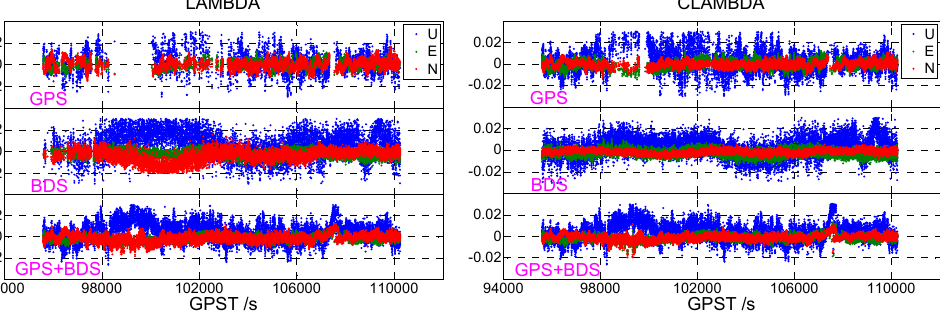
Figure 3. East (E) / north (N) / up (U) deviation sequence diagram (( left ) LAMBDA, ( right ) Figure 3. East (E)/north (N)/ up (U) deviation sequence diagram (( left ) LAMBDA, ( right ) CLAMBDA).